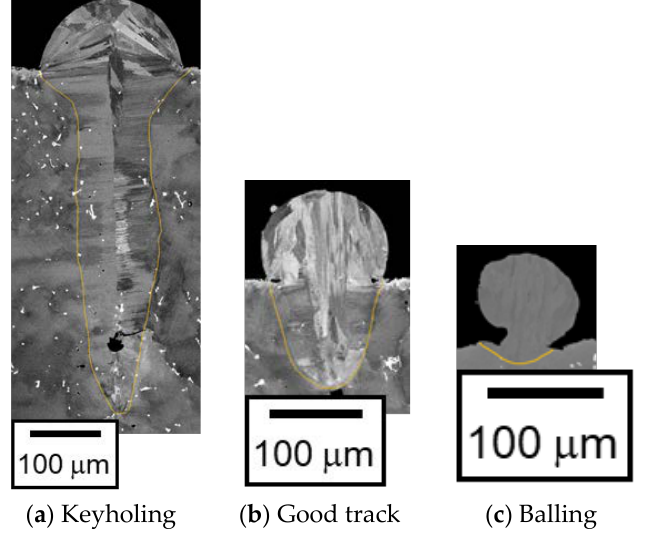
Figure 3. Example images of the single-track experiments: P = 300 W, V = 250 mm/s ( a ), P = 300 W, V = 1000 mm/s ( b ), and P = 300 W, V = 3000 mm/s ( c ).